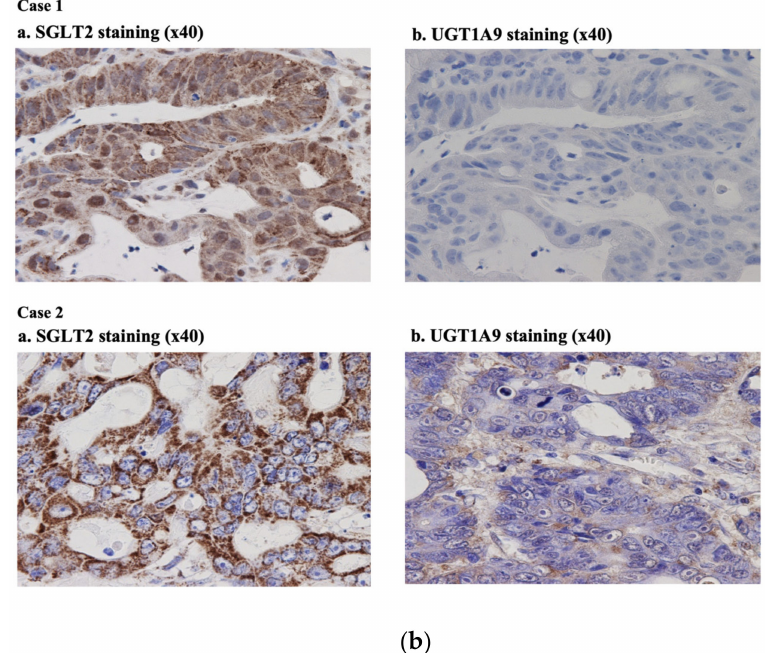
Figure7. Clinicalcases-Patientswithtype2diabetesmellitusandcancerweretreatedbysodium-glucose cotransporter 2 (SGLT2) inhibitor. ( a ) Clinical cases – Patients with type 2 diabetes mellitus and